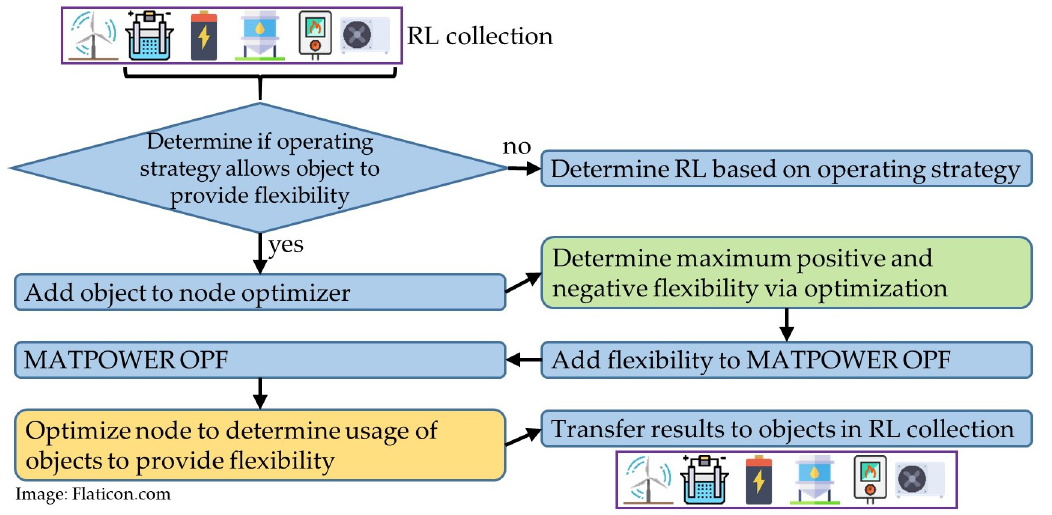
Figure 7. Process for optimized operating strategy, providing flexibility.